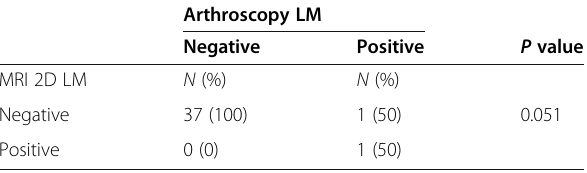
Table 4 Arthroscopic findings correlated with MRI protocol A